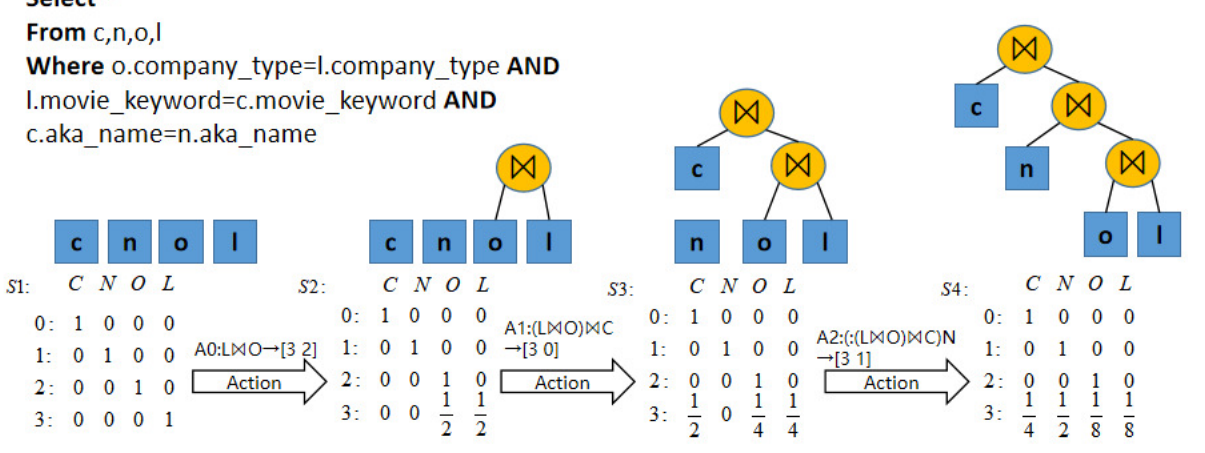
Figure 3. Action vector representation process.